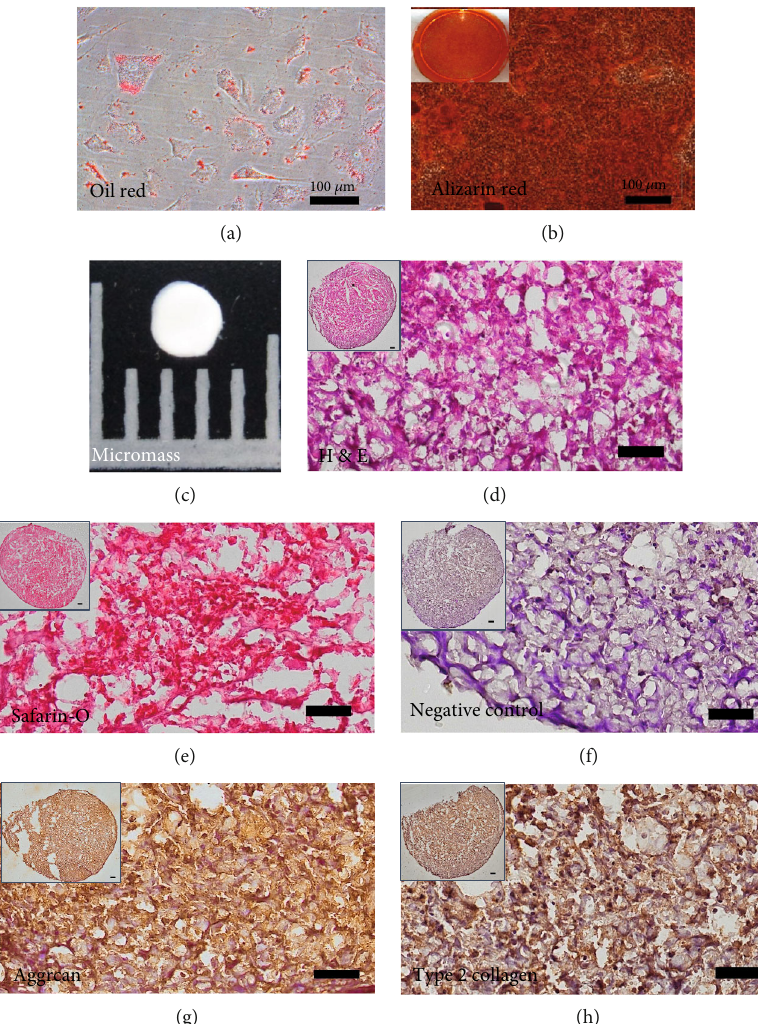
Figure 6: Trilineage di ff erentiation of iPSC-derived MSCs. (a) After the adipogenesis of iPSC – MSC for 2 weeks, the oil droplets in the cells were staining positive for Oil red. Scale bar = 100 μ m . (b) After the osteogenesis of iPSC – MSC for 2 weeks, the mineral deposition in cells was staining positive for Alizarin Red. Insert picture was Alizarin Red staining of one well of a 6-well plate. Scale bar = 100 μ m . (c) After chondrogenesis of iPSC-derived MSCs for 21 days, the iPSC – MSC formed a cartilage micromass. The picture is 5 mm in length. (d) The Hematoxylin and Eosin (H & E) staining of the micromass. (e, g, h) Micromasses were positive for sulfated glycosaminoglycans (Safranin O) (e), aggrecan (g), and type 2 collagen (h). (f) Negative control staining for immunohistochemistry (without the fi rst antibody). Insert pictures in (d – h) were the picture of the whole micromass section. Scale bar = 100 μ m